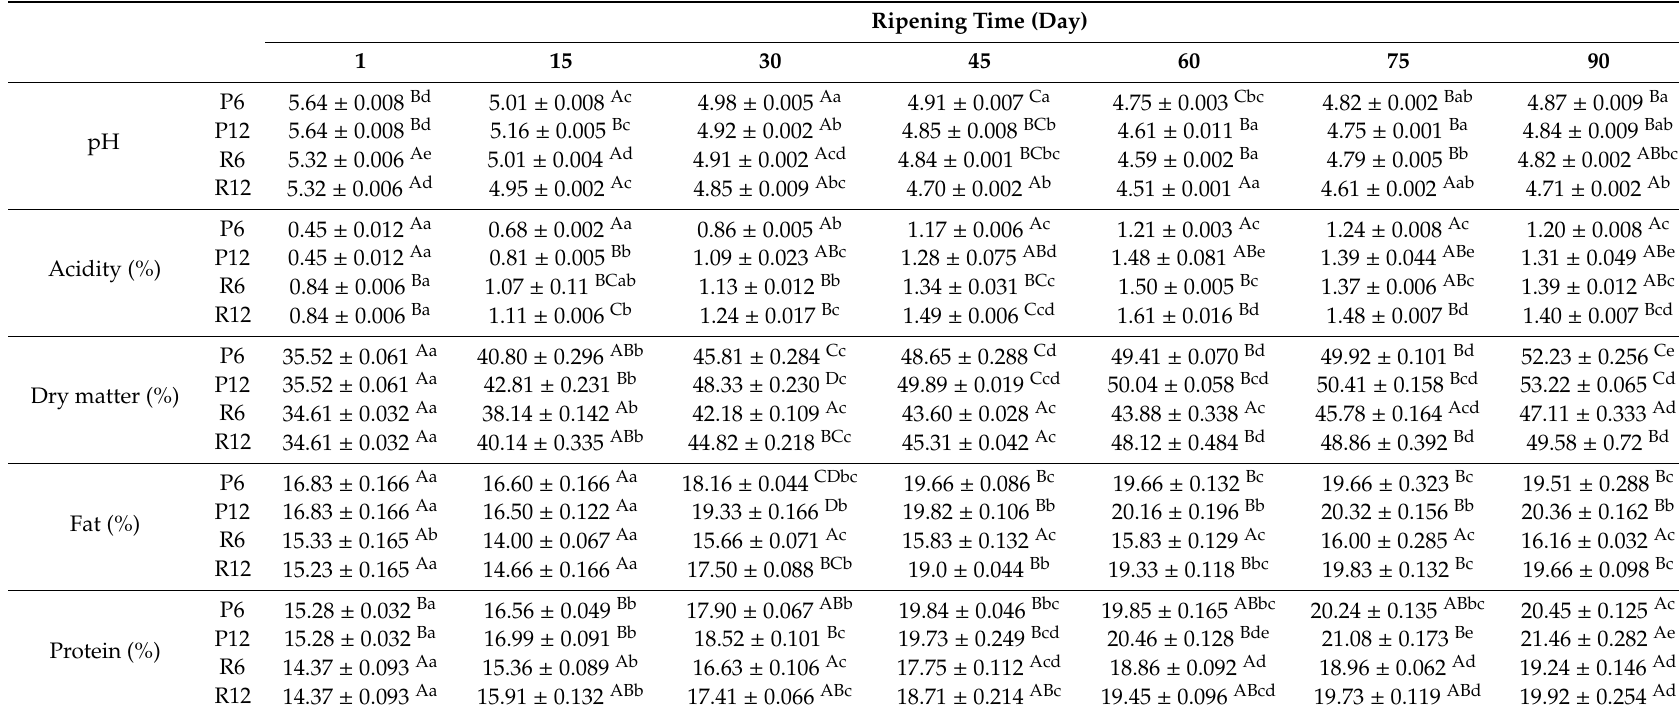
Table 1. Physicochemical properties of Motal cheese during the 90-day ripening